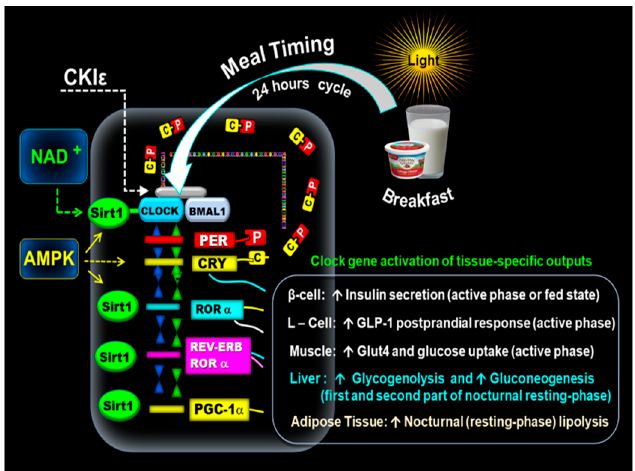
Figure 1. Mechanism of the molecular clock. The above illustration shows that the early-timed breakfast at dawn activates the CLOCK: BMAL1 complex associated with SIRT1 and the transcription of PERs and CRYs. The resulting proteins PER (P) and CRY (C) form PER: CRY (C-P) dimers in the cytoplasm. Subsequently, PER: CRY dimers translocate back to the nucleus to repress CLOCK: BMAL1. The blockage of CLOCK: BMAL1 is reversed by casein kinase I epsilon (CKI ε ). NAD+ activates SIRT1, which interacts with the CLOCK: BMAL1. In addition, AMPK positively interacts with SIRT1. CLOCK: BMAL1-driven transcription of PERs, CRYs, REV-ERB α , ROR α genes, and PGC-1 α promotes the expression of tissue-specific clock-controlled genes. It leads to the upregulation of β -cell insulin secretion, L-cell postprandial incretin GLP-1 response, and the increase of GLUT4 activity and muscle glucose uptake. The clock gene-driven nocturnal hepatic glucose production promotes glycogenolysis and gluconeogenesis in the first and second part of the nocturnal resting phase. PGC-1 α plays a role in lipid metabolism (lipogeneses and nocturnal lipolysis .